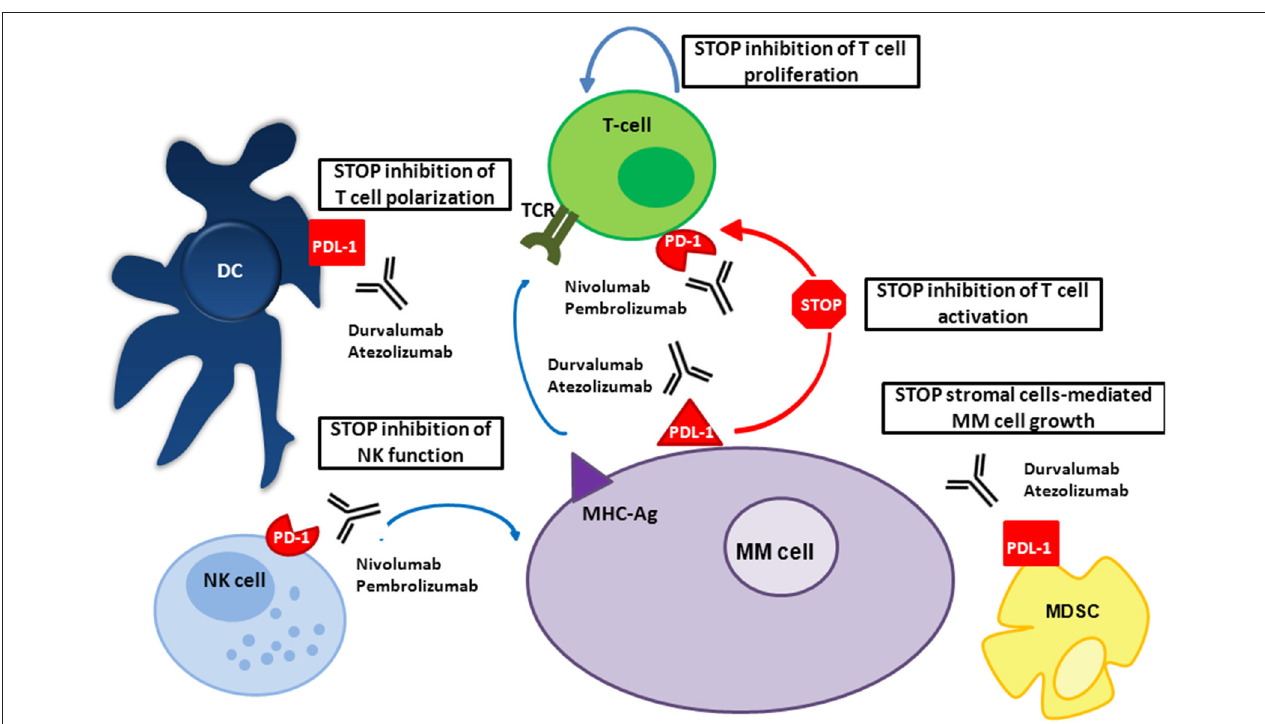
FIGURE 1 | Mechanism of action of PD-1/PD-L1 inhibitors in MM. In patients with MM, PD-L1 is expressed on MM and bone marrow microenvironment accessory cells; PD-1 on NK cells and T cells. PD-1/PD-L1 signaling in patients with MM inhibits the function of these immune cells, allowing MM to escape death. Both anti-PD-1 and anti-PD-L1 mAbs prevent this